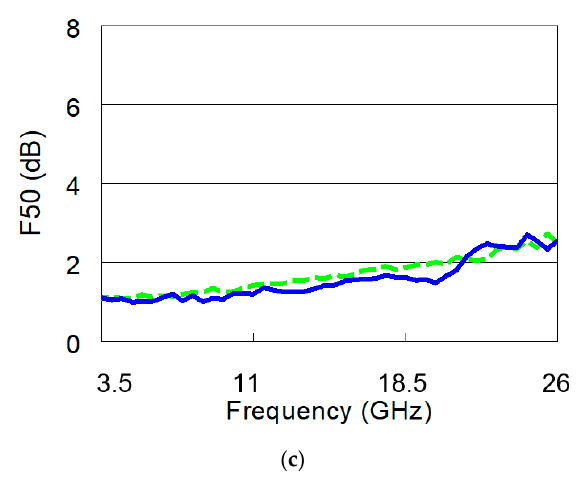
Figure 7. Scattering parameters measured by NRL (green dashed line) and UniME (blue solid line) for a HEMT with gate width of 4 × 50 μ m (3.5–26 GHz). ( a ) S 11 and S 22 , ( b ) S 21 and 100 · S 12 , ( c ) F 50 . V DS = 2 V and I DS = 40 mA.